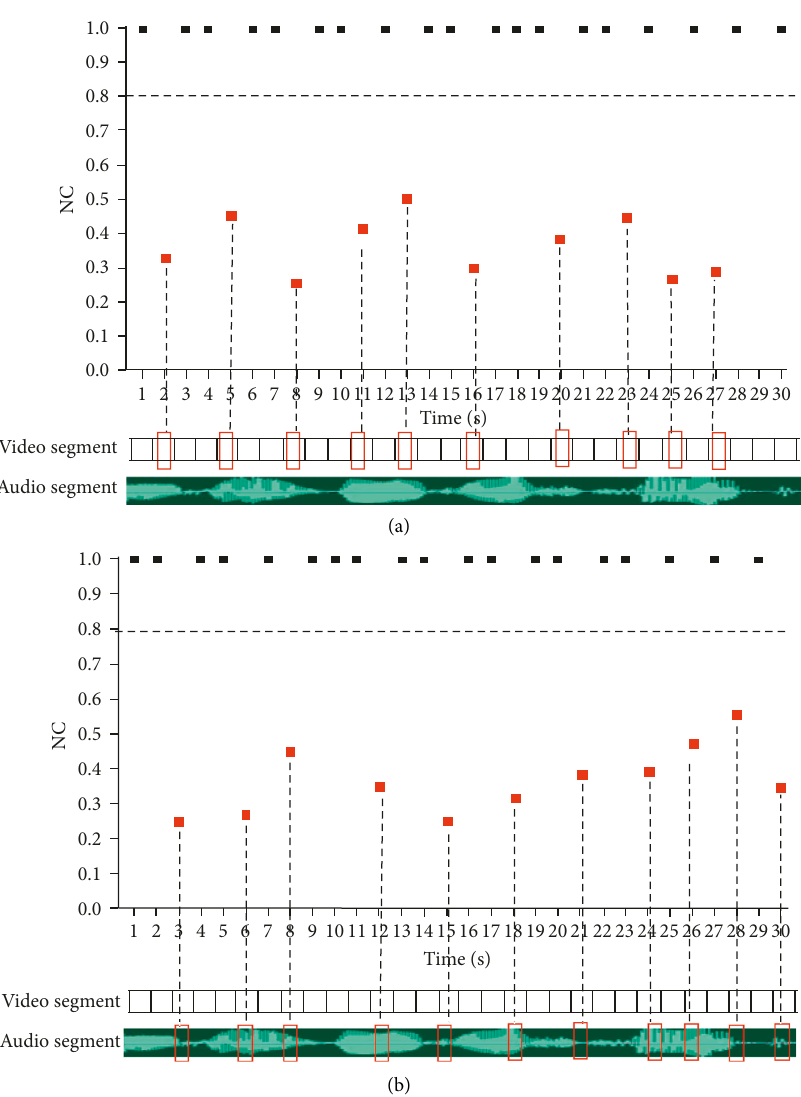
Figure 8: Experimental results of matching detection and location of audio and video. (a) Experimental results of matching detection after video tampering. (b) Experimental results of matching detection after audio